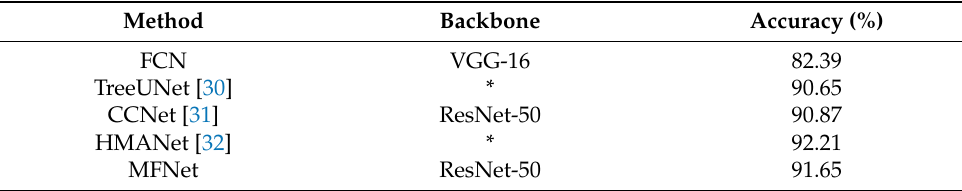
Table 3. Accuracy in the Potsdam dataset (* defines the unknown